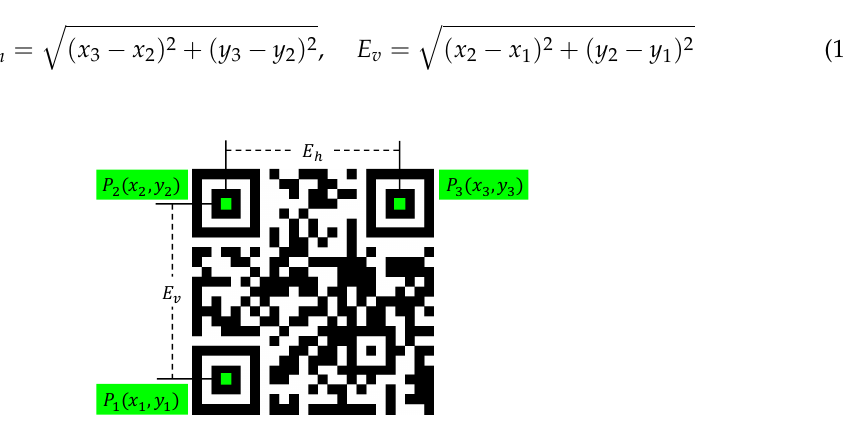
Figure 6. QR code marker and milliradian measurement. (The center coordinates of the locator symbols are marked in green.)